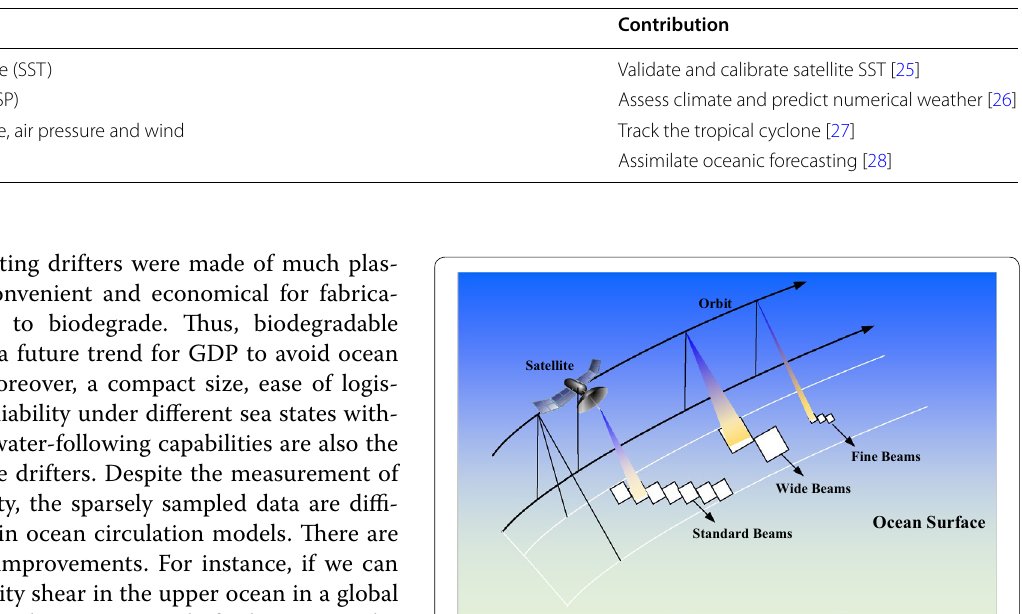
Table 1 Roles of GDP data